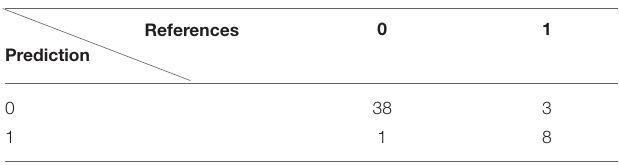
TABLE 4 | Logistic regression modeling prediction